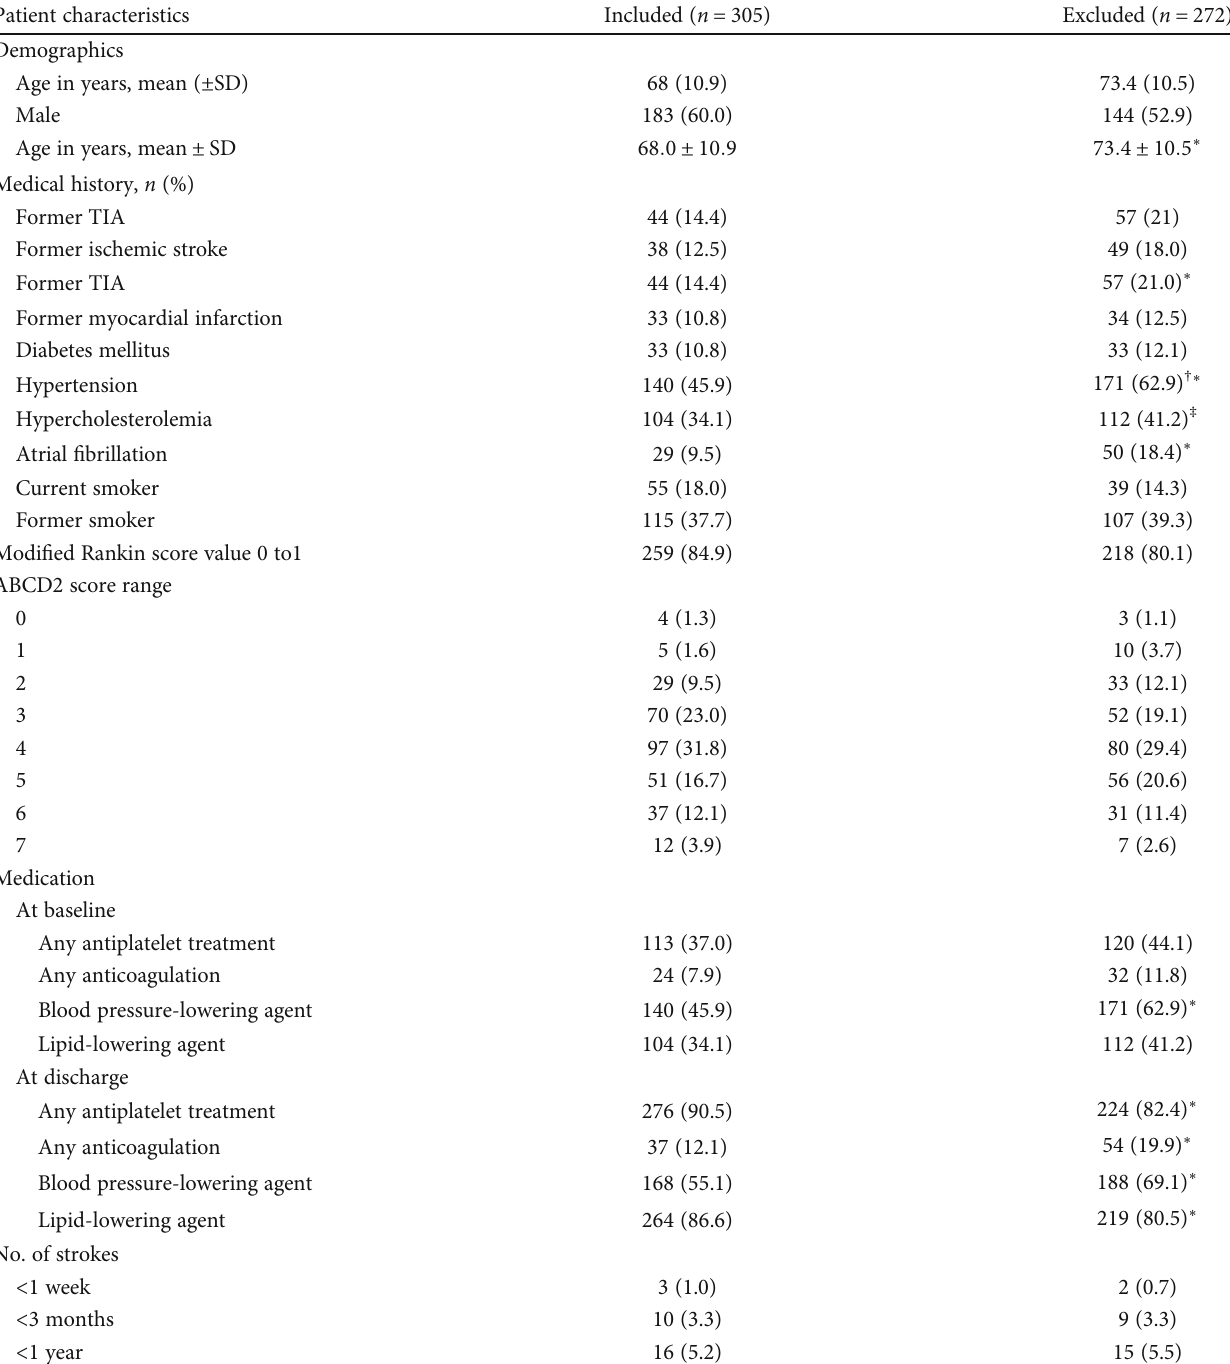
Table 2: Clinical characteristics in included patients with complete data for analysis of the ABCD2 and ABCD3-I scores and excluded patients, n (%) or mean ± SD